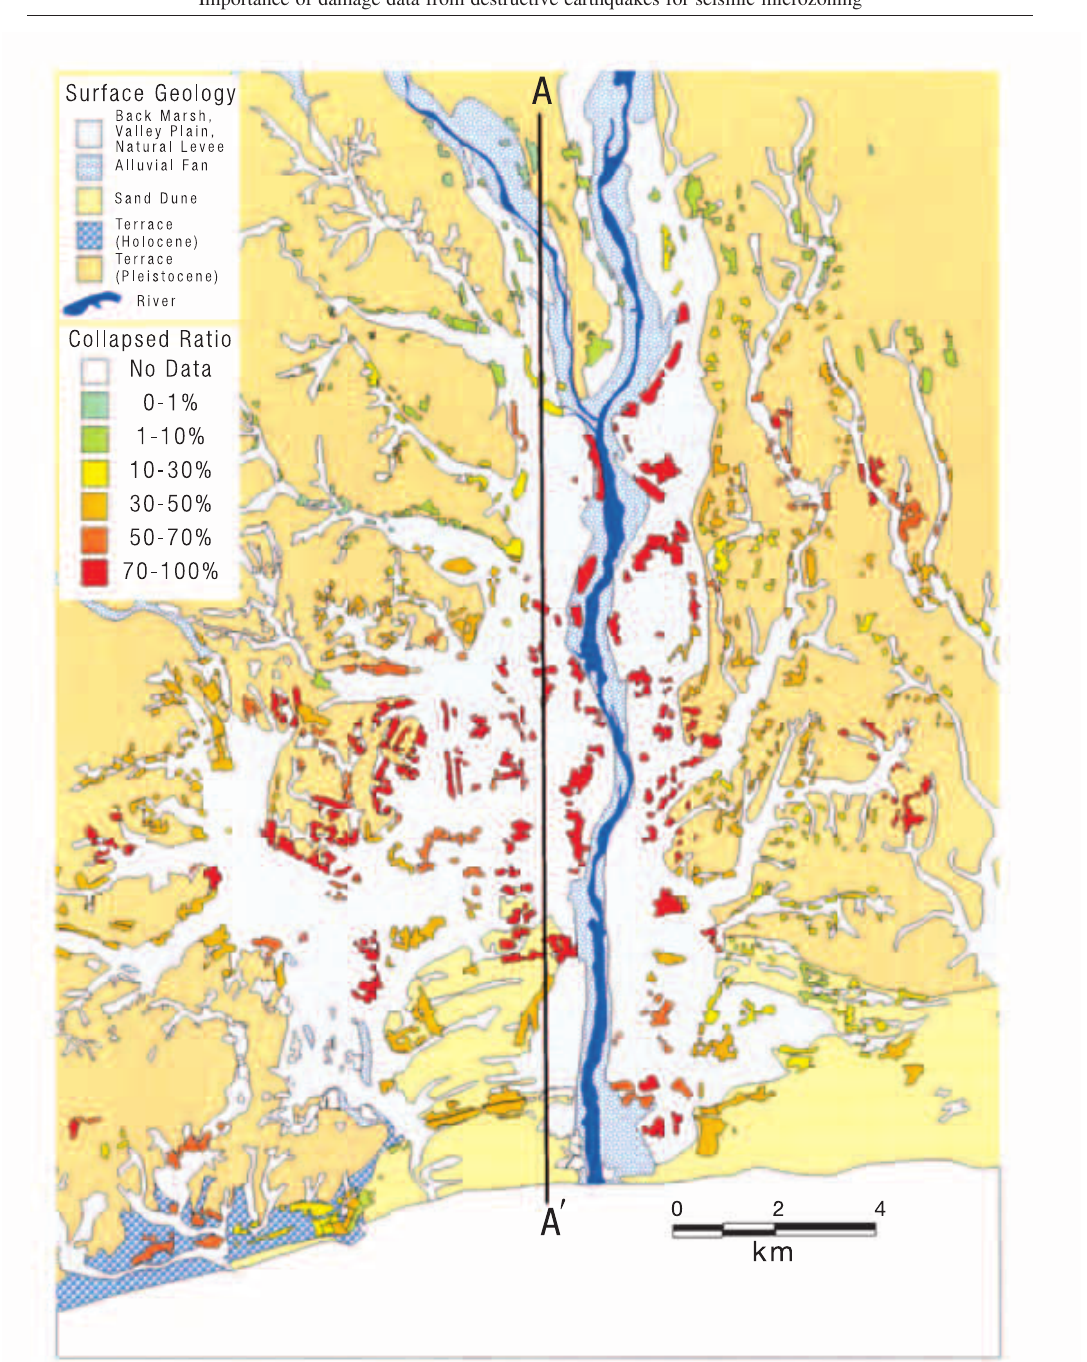
Fig. 8. Detailed damage distribution and geomorphological conditions along the Sagami